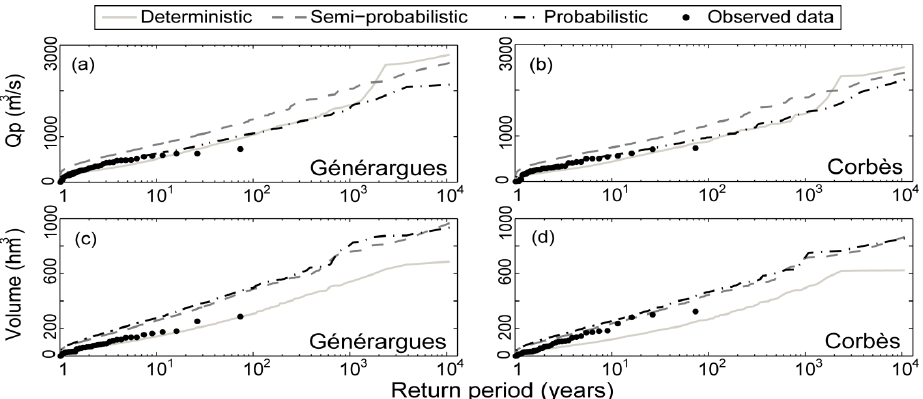
Figure 10. Frequency curves of peak flows ( a , b ) and the associated hydrograph volume ( c , d ). Deterministic (solid line), semi-probabilistic (dashed line) and probabilistic (dash-dot line) and observed data (circles). Results for the Générargues ( a , c ) and Corbès ( b , d ) basins.